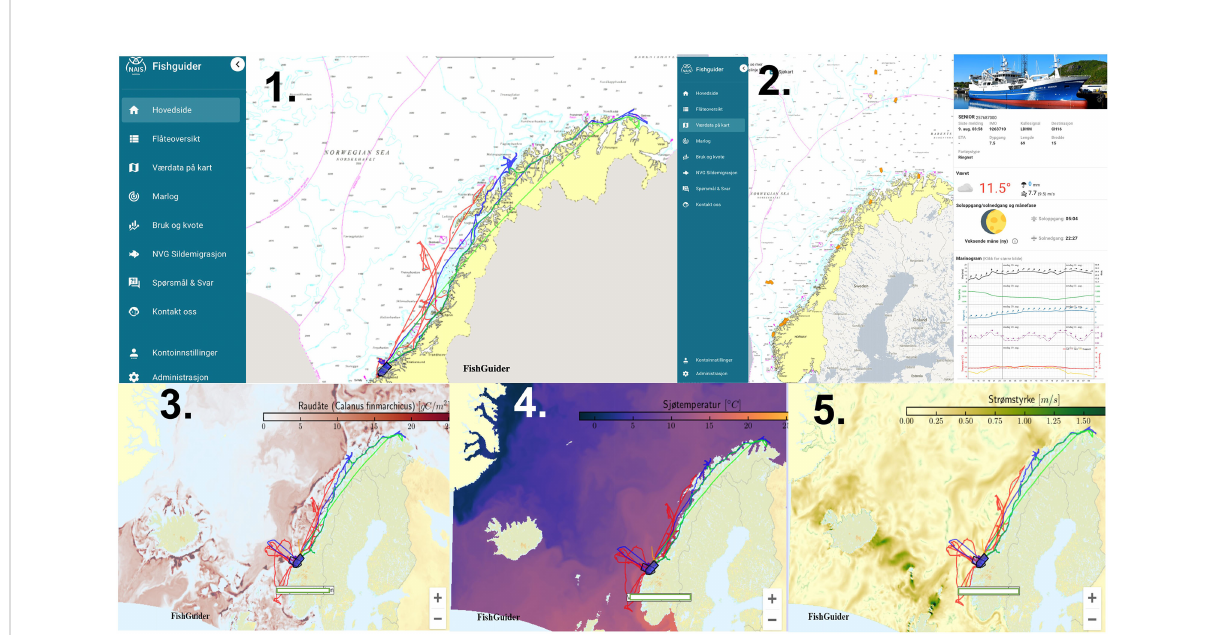
FIGURE 4 A selection of output layers in the Fishguider portal, with Norwegian text: 1) Homepage with tabs for various layers centered on the Norwegian Sea. The red, blue and green lines are the tracks of individual vessels based on GPS coordinates. 2) Weather data and forecast from the position of one of the NAIS vessels based on meterological institute data. 3) Modelled Calanus fi nmarchicus distribution and abundance in grams of carbon per meter squared 4) Sea surface temperature output on a single day in degrees Celsius. 5) Horizontal components of current velocities in meters per